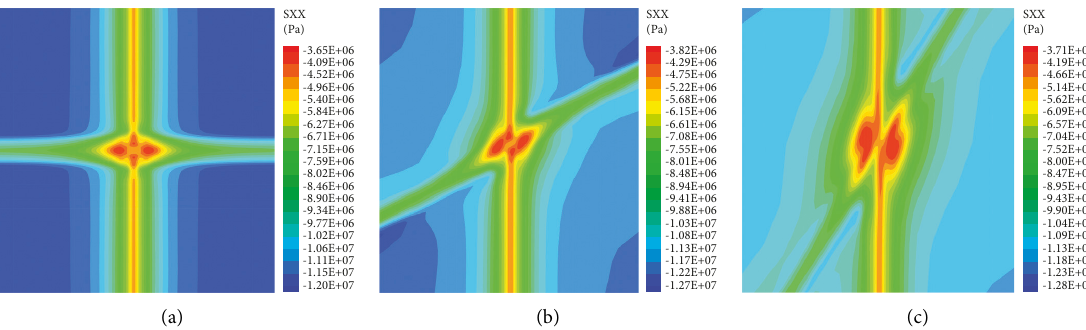
Figure 7: Disturbance influence of horizontal azimuth angle on surrounding rock horizontal stress of staggered roadways. (a) 90 ° horizontal azimuth angle of staggered roadways, (b) 60 ° horizontal azimuth angle of staggered roadways, and (c) 30 ° horizontal azimuth angle of staggered roadways.